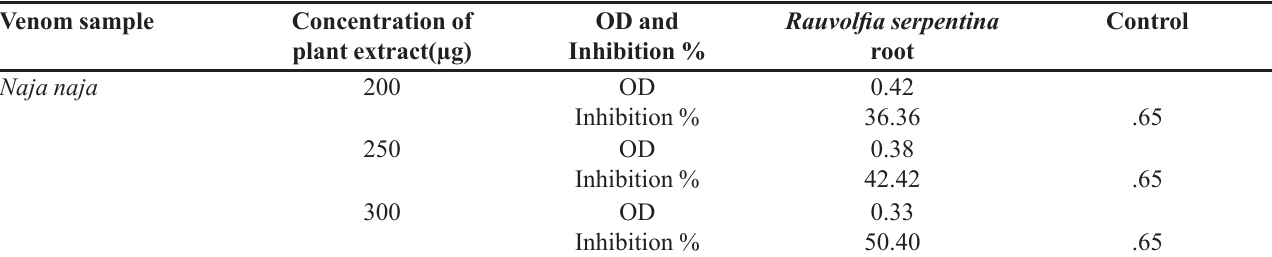
TABLE II - Protease activity on Naja naja venom Venom sample